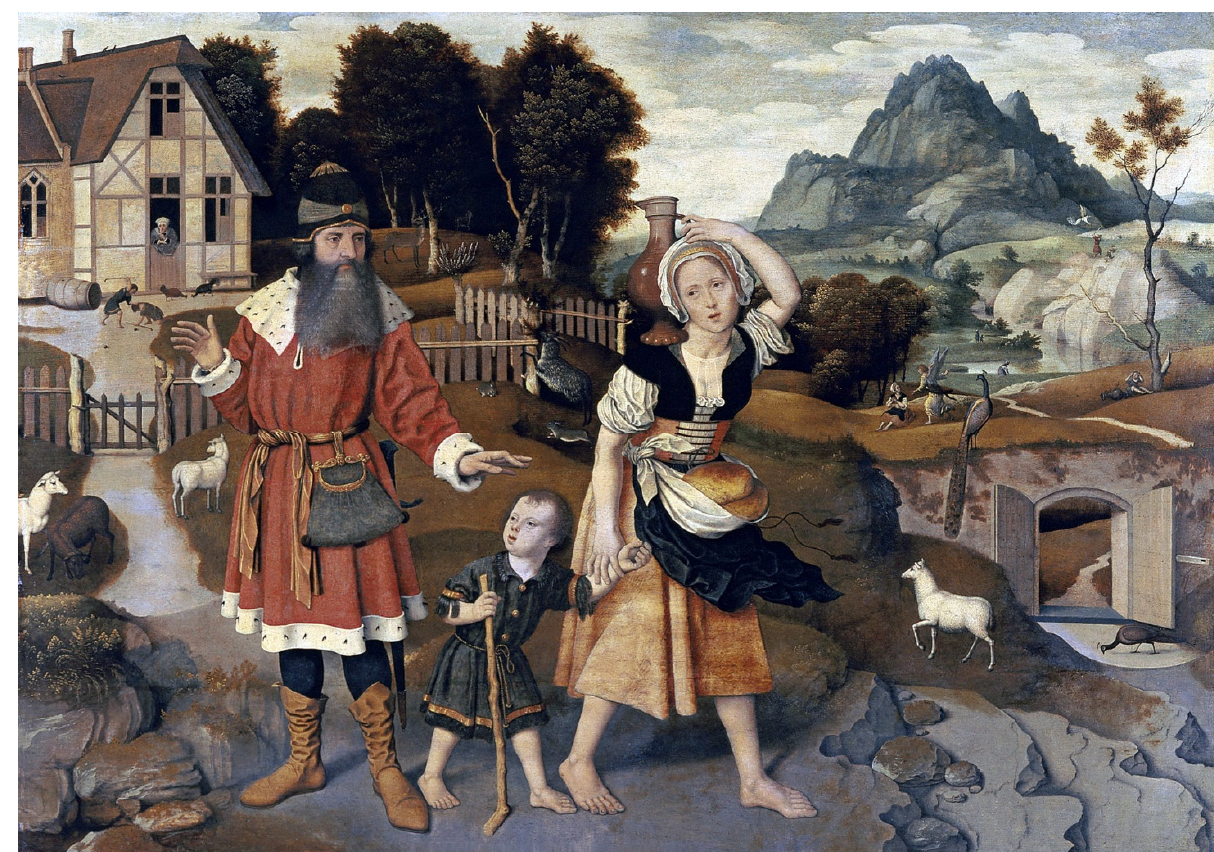
Figure 8. Jan Mostaert, ca. 1520–1525, Madrid, Colección Thyssen Bornemisza, 294 (1930.77).